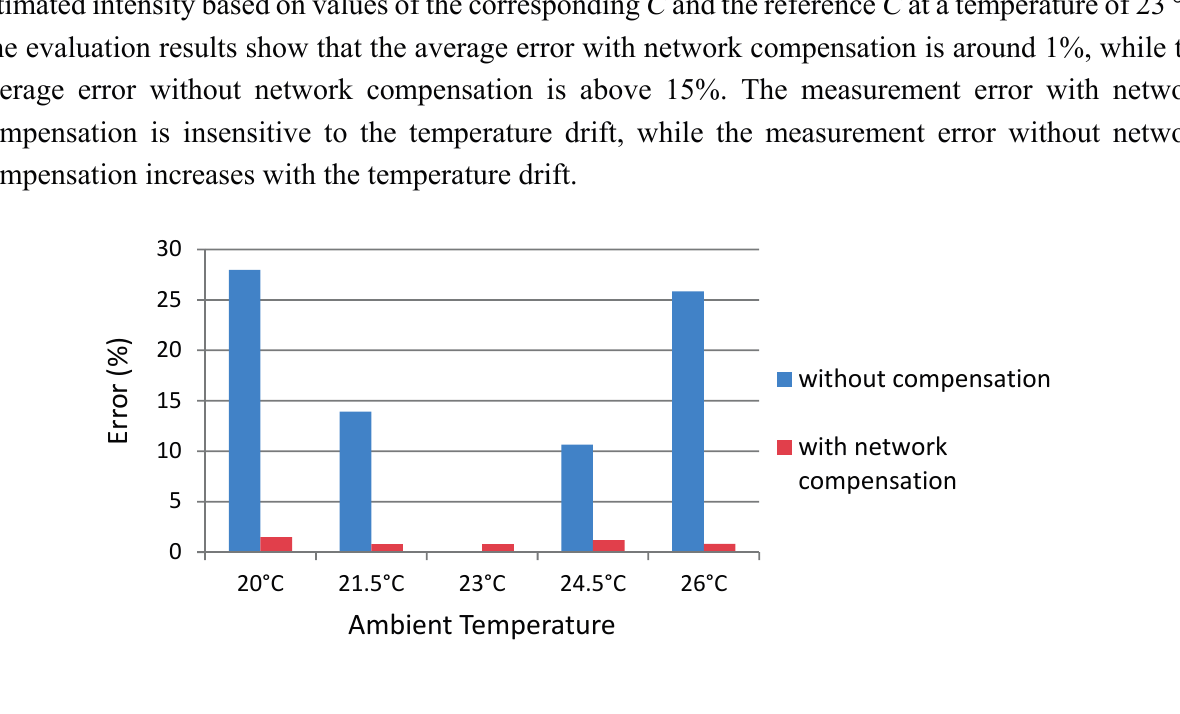
Figure 12. Ultrasound intensity error with and without network temperature compensation.